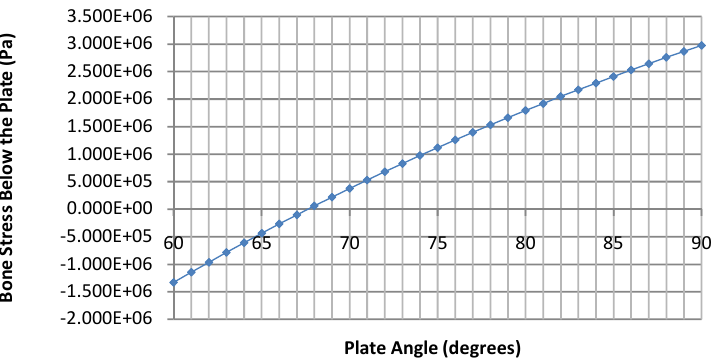
Fig.10 Predicted change in bone stress below the plate with a change in plate angle Results from our FE model (see Fig. 11) indicate that an increase in plate angle will cause a decrease in stress in the underlying bone, i.e. a higher degree of stress shielding develops in the neighbouring bone. The variation between the theoretical prediction of bone stress and our FE results is quite prominent here, and can once again be explained by the contact between the bone and plate, the majority of the bending moment is effectively transferred to the plate.